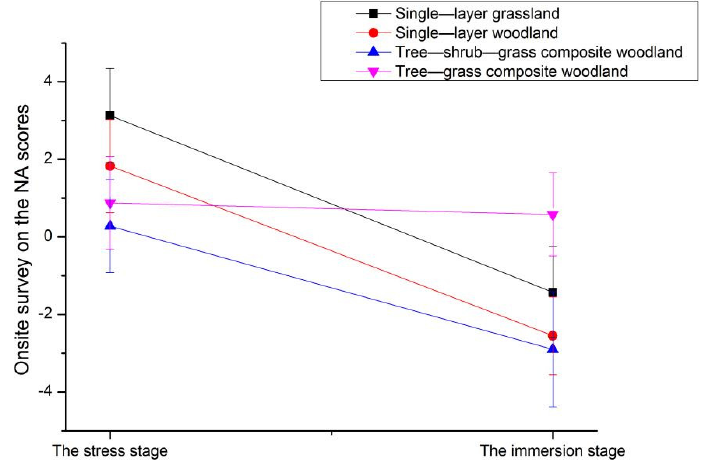
Figure 8. Effect of onsite surveys on the NA scores of participants.